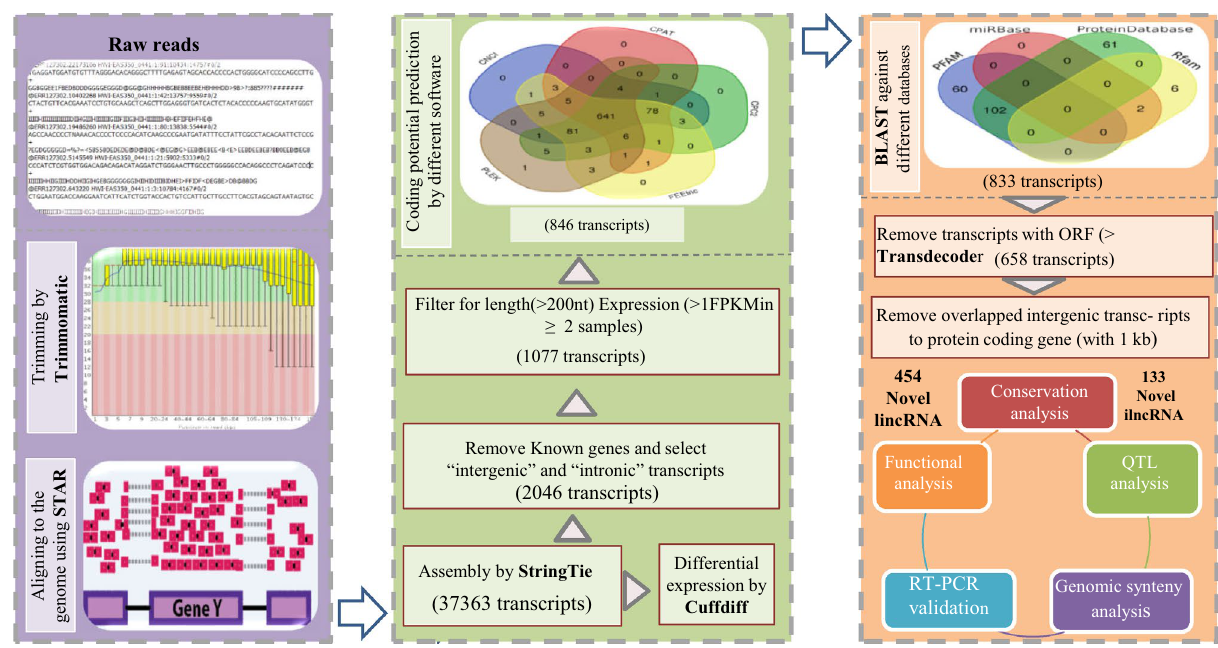
Figure 1. The bioinformatics pipeline for identifying annotated, known and novel lncRNAs. The middle and right Venn diagrams illustrate the results of the potential coding ability of the transcript using five software and blasting the transcripts against four different databases,